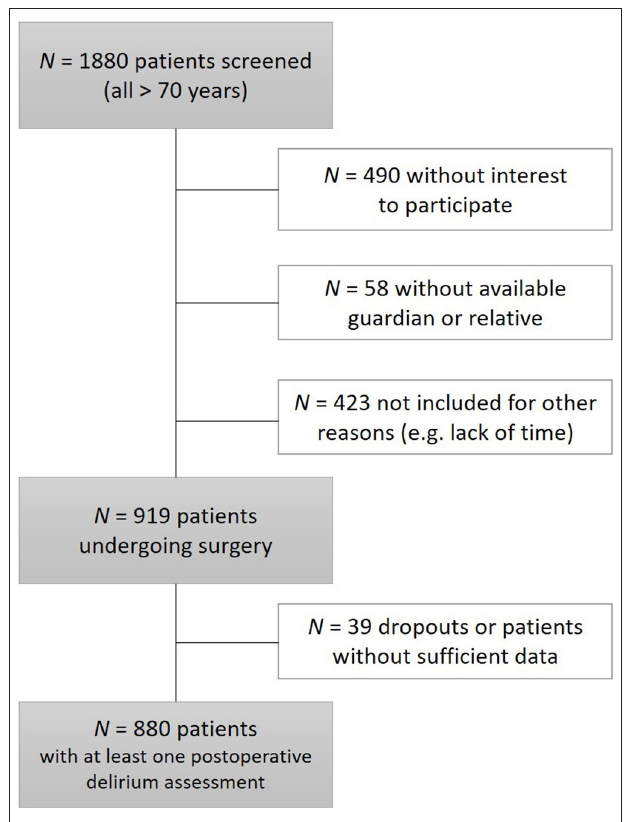
FIGURE 1 | Overview of enrollment and exclusion of patients in the